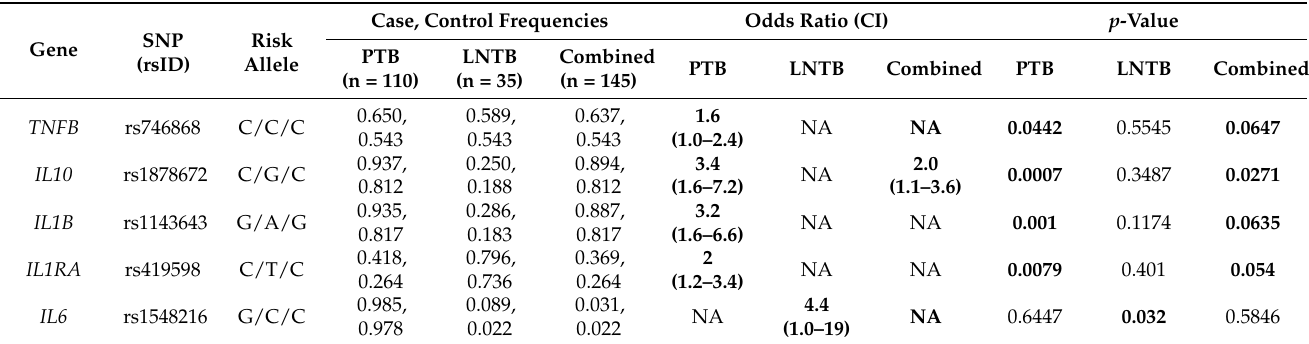
Table 1. Comparative allelic association statistics of cytokine variants in the discovery group between PTB and LNTB.